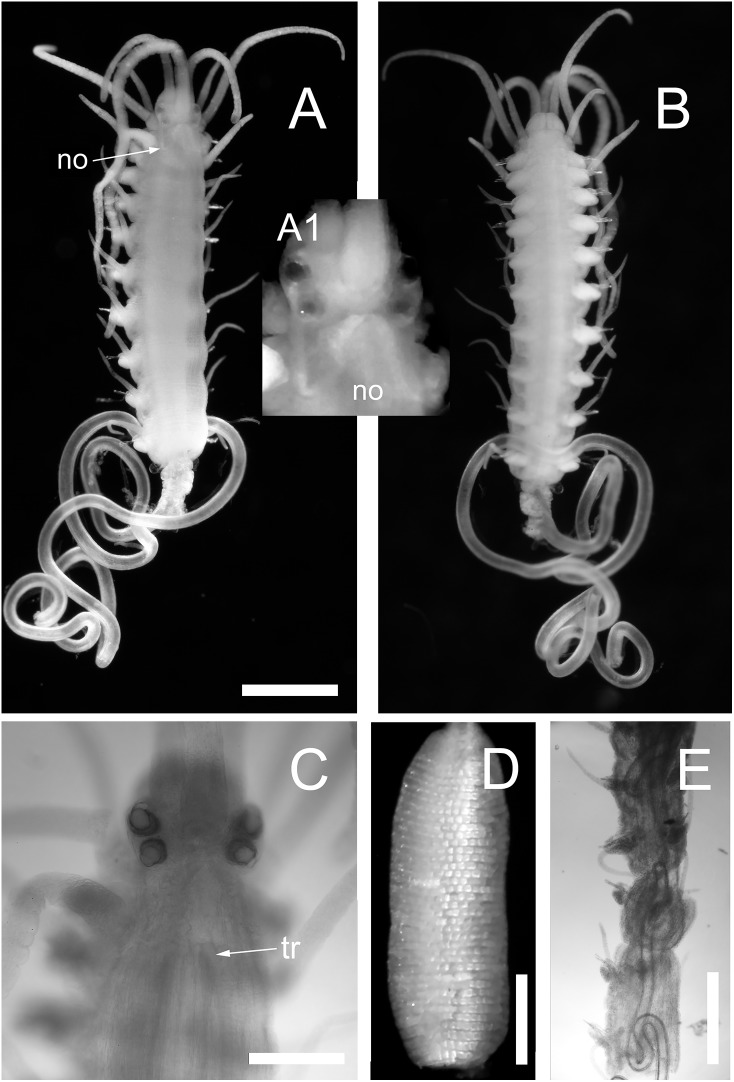
Proceraea exoryxae sp. nov.(A) Anterior fragment, dorsal view [MNCN 16.01/17719], and detail of the head from the same specimen (A1). (B) Anterior fragment, ventral view [MNCN 16.01/17719]. Body is broken after chaetiger 10, exposing the pharynx (A and B). (C) Anterior end, dorsal view [MNCN 16.01/17719]. (D) Proventricle [MNCN 16.01/17719]. (E) Pharynx sinuation in chaetigers 9–14, dorsal view [MNCN 16.01/17720]. no, nuchal organs; tr, position of trepan. Scale bars A, B, E = 0.5 mm, C, D = 0.2 mm.